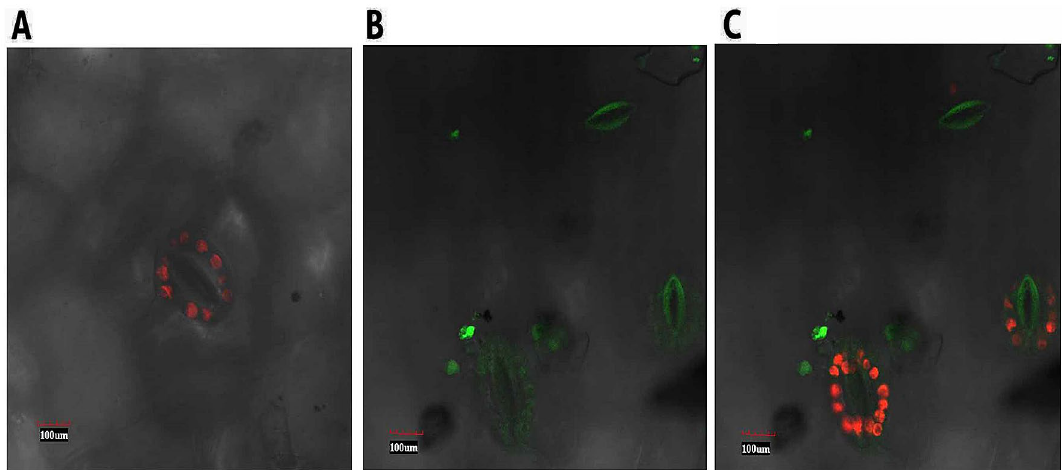
Figure 17. Confocal microscopy for localization of GUSP-2 in leaves of transgenic plants, ( A ) control plant, ( B ) transgenic plant with GFP fluorescence ( C ) transgenic plant with GFP fluorescence and chloroplast